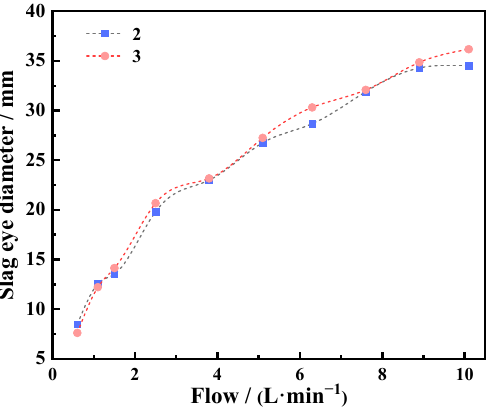
Figure 5. Slag surface exposure of single hole 2 ( a ) and hole 3 ( b ) at different blowing rates.